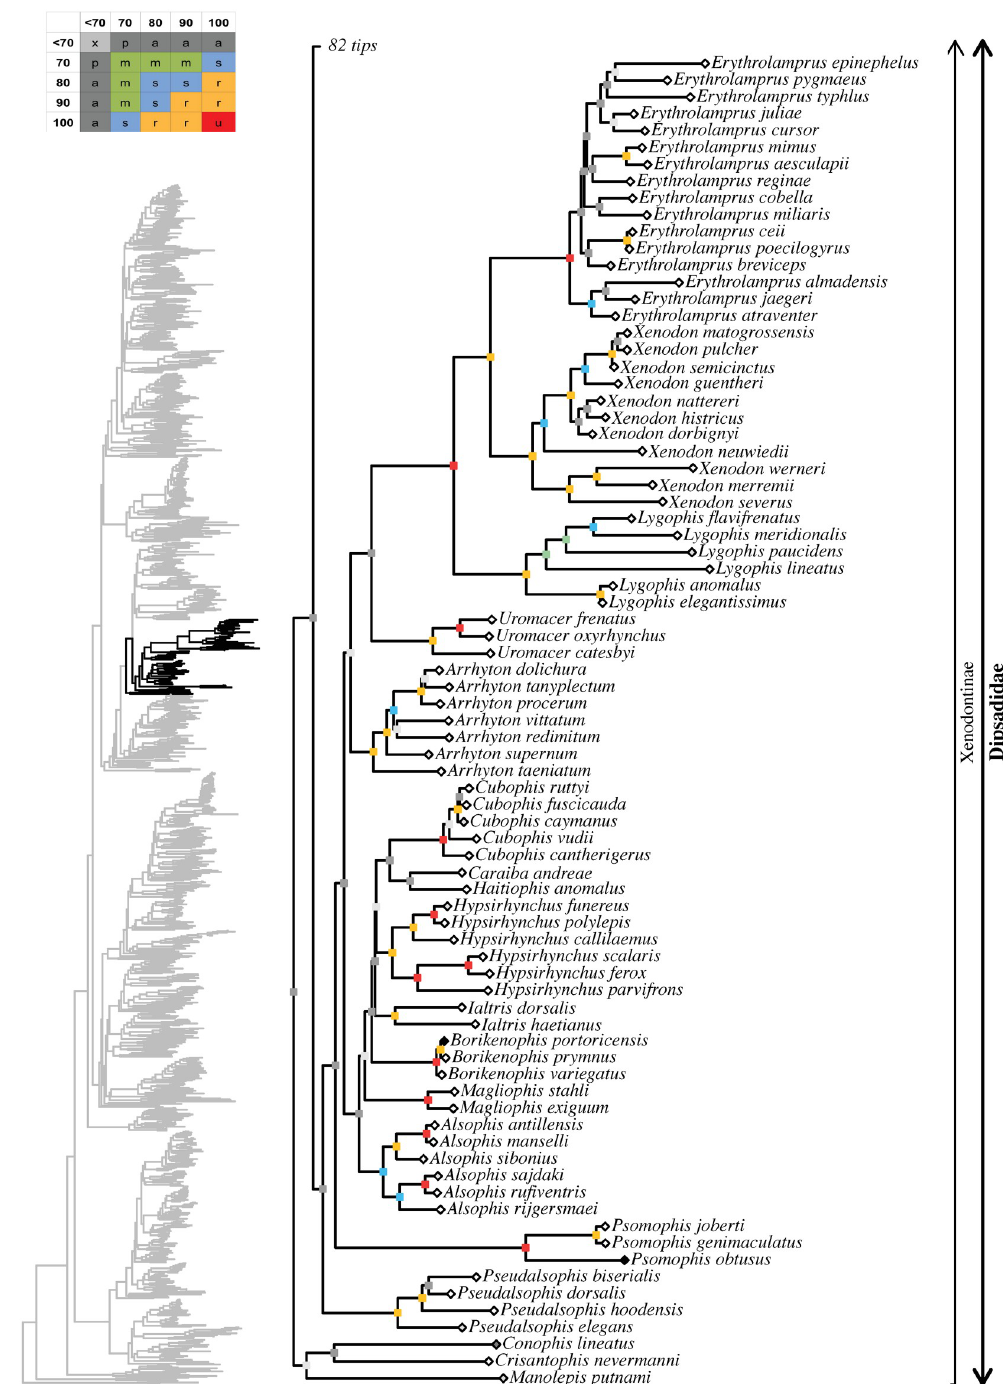
Fig 16. Maximum likelihood species-level phylogeny of Colubroides (continued). Family Dipsadidae (continued).